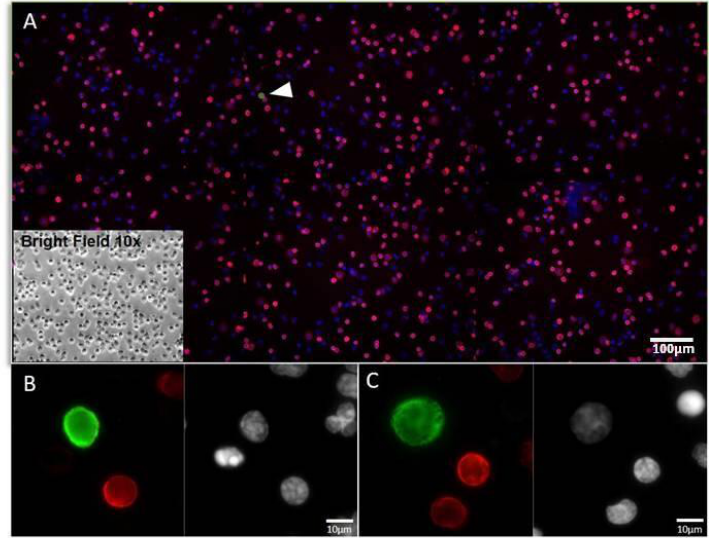
Figure 2. Example of a liquid biopsy sample staining with CD45 and PK in NSCLC patient. ( A ) Representative image at 10× magnification of WBCs and CTCs (white arrow) on SBS ® slide stained by immunofluorescence: CD45 (Red); PK (Green); Nuclei (Blue). In the box, brightfield 10× image of the same cells. ( B , C ) Examples of CTCs cells acquired at 40× magnification. WBCs, white blood cells; CTCs, circulating tumour cells; PK, pan-Cytokeratin.